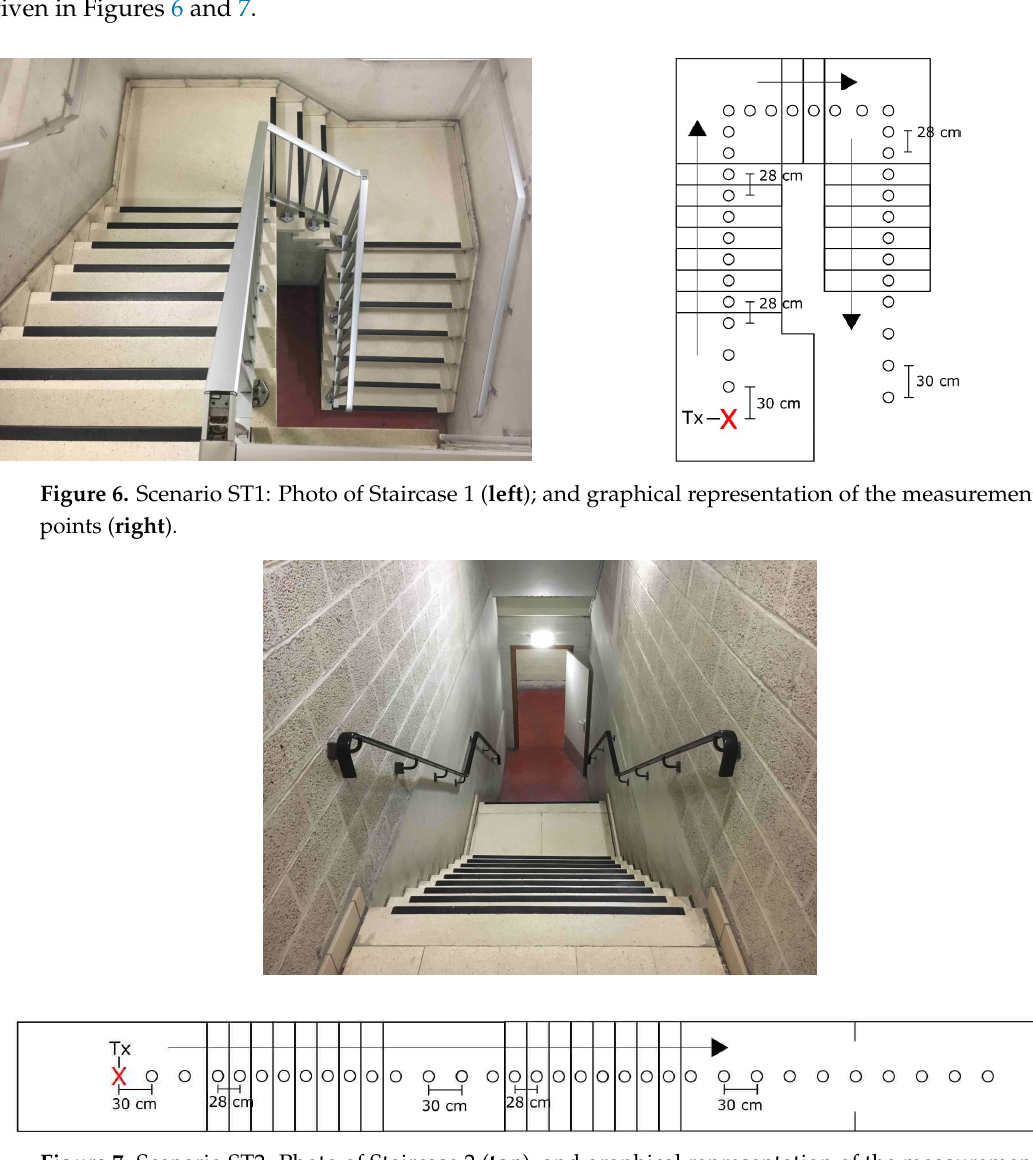
Figure 7. Scenario ST2: Photo of Staircase 2 ( top ); and graphical representation of the measurement points ( bottom